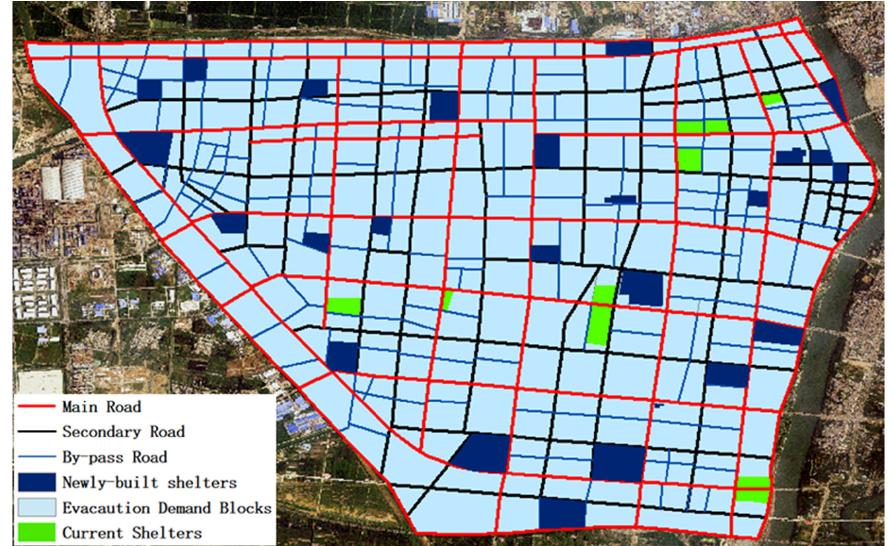
Figure 9. The optimal shelter location scheme.